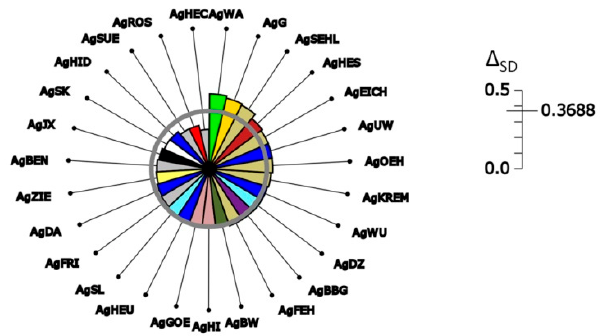
Figure 3. Snail diagram showing the differentiation between 27 occurrences of A. graveolens at the gene pool level. A sector represents one of the occurrences. The side length of a sector quantifies the contribution of each occurrence to differentiation. The grey circle marks the mean differentiation and the average of all 27 radii length. Colors refer to the ecogeographic unit where the occurrence was sampled. Identical colors were used in Figure 1.